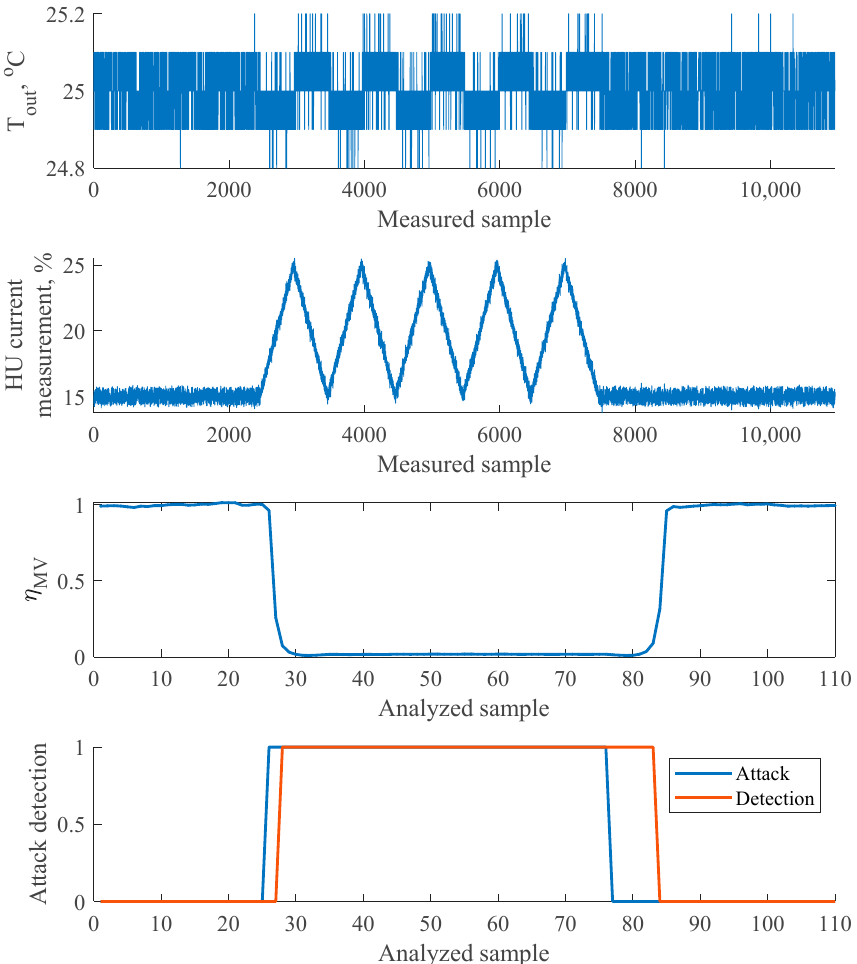
Figure 6. Effect of the triangular attack signal on process control.